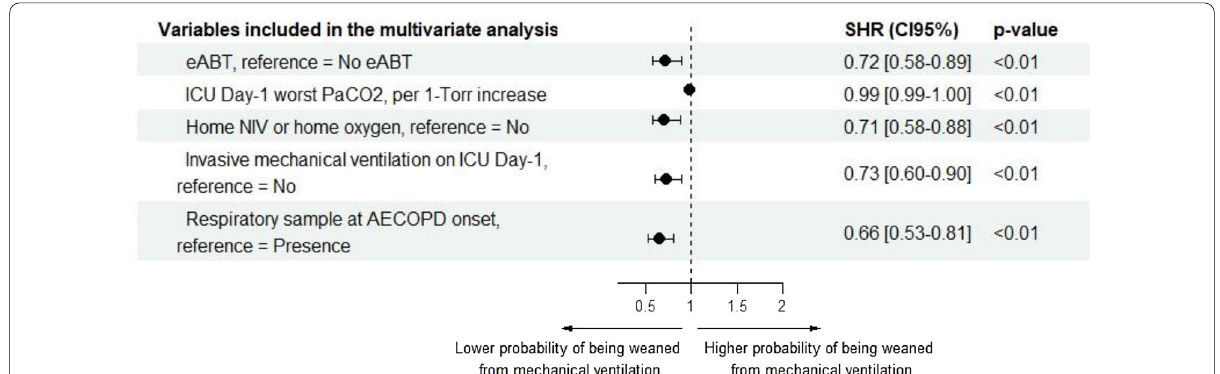
Fig. 3 Forest plot of the adjusted SHR computed with multivariate computing risk regression of the probability of being successfully weaned from mechanical ventilation . eABT was defined as the first line of antibiotic therapy introduced during the first 24 h of ICU admission. COPD frequent exacerbator status was defined as at least two acute exacerbations of COPD with hospital admission within one year. Respiratory sample at AECOPD onset was defined as bacterial respiratory sample performed between 48 h before ICU admission and the end of ICU day-1. Univariate Fine and Gray analysis was first performed on each variable of interest (Additional file 1: Table S1). Then, the following variables were selected for inclusion in the multivariate model because of their assumed relevance: eABT status, centre, age, truncated SAPS2 (leaving out age, Glasgow Coma Scale, PaO2/FiO2 and temperature components to avoid collinearity with the other variables), home NIV or home oxygen status, COPD frequent exacerbator status, ICU day-1 cardiovascular and renal SOFA subscore (to avoid multicollinearity with SAPS2), ICU day-1 highest body temperature, reported as a SAPS2 value when data were collected), invasive mechanical ventilation on ICU-day-1, respiratory sample at AECOPD onset, and cardiogenic pulmonary oedema on ICU day-1. Interactions were systematically checked for. We did not report any significant interaction between eABT and other variables included in our model. Then, we reduced our model by deleting all variables with multivariate p-value > 0.1. SHR lower than 1 indicates a lower probability of being successfully weaned from mechanical ventilation, accounting for the competing risk of death. SHR subdistribution hazard ratio; CI95% 95% confidence interval, NIV non-invasive ventilation, PaCO2 CO2 arterial partial pressure; PaO2/FiO2 ratio of O2 arterial partial pressure on fraction of inspired O2, SAPS2 simplified acute physiology score 2, SOFA Sequential Organ Failure Assessment, eABT early antibiotic therapy, COPD chronic obstructive pulmonary disease, ICU intensive care